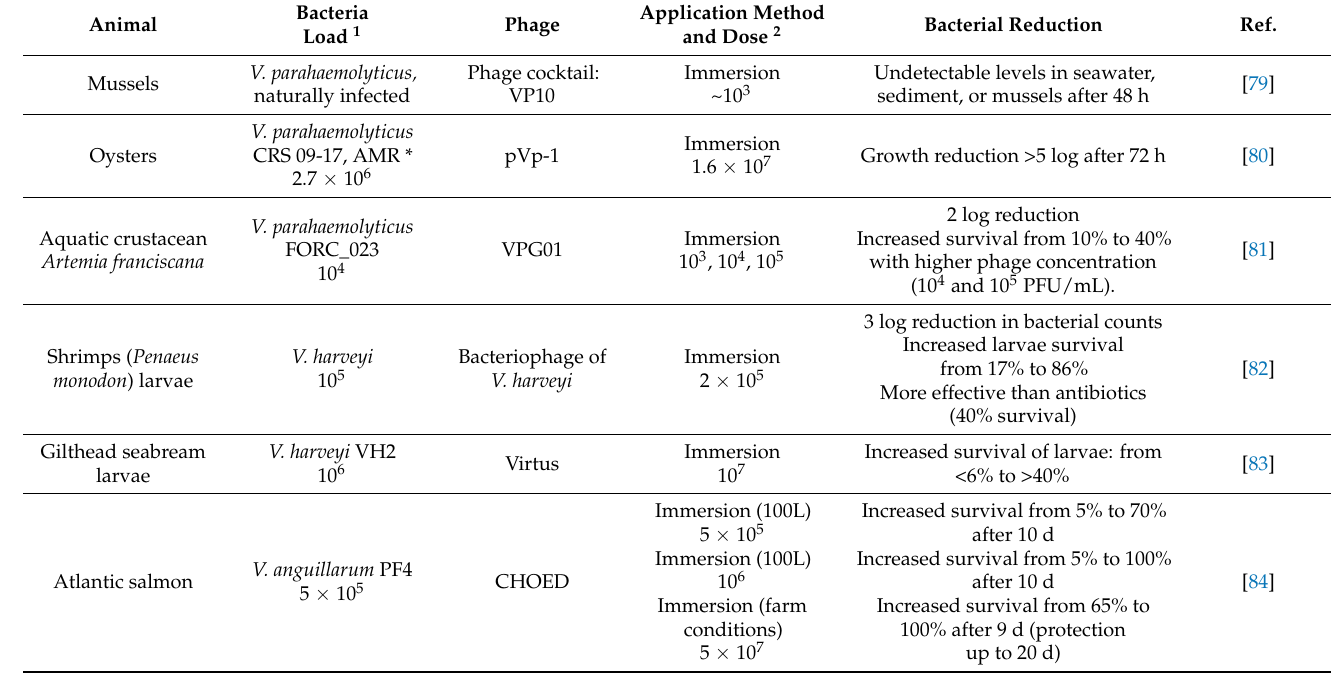
Table 2. Examples of the use of phages for controlling or reducing the incidence of different Vibrio spp. in aquaculture and closely related